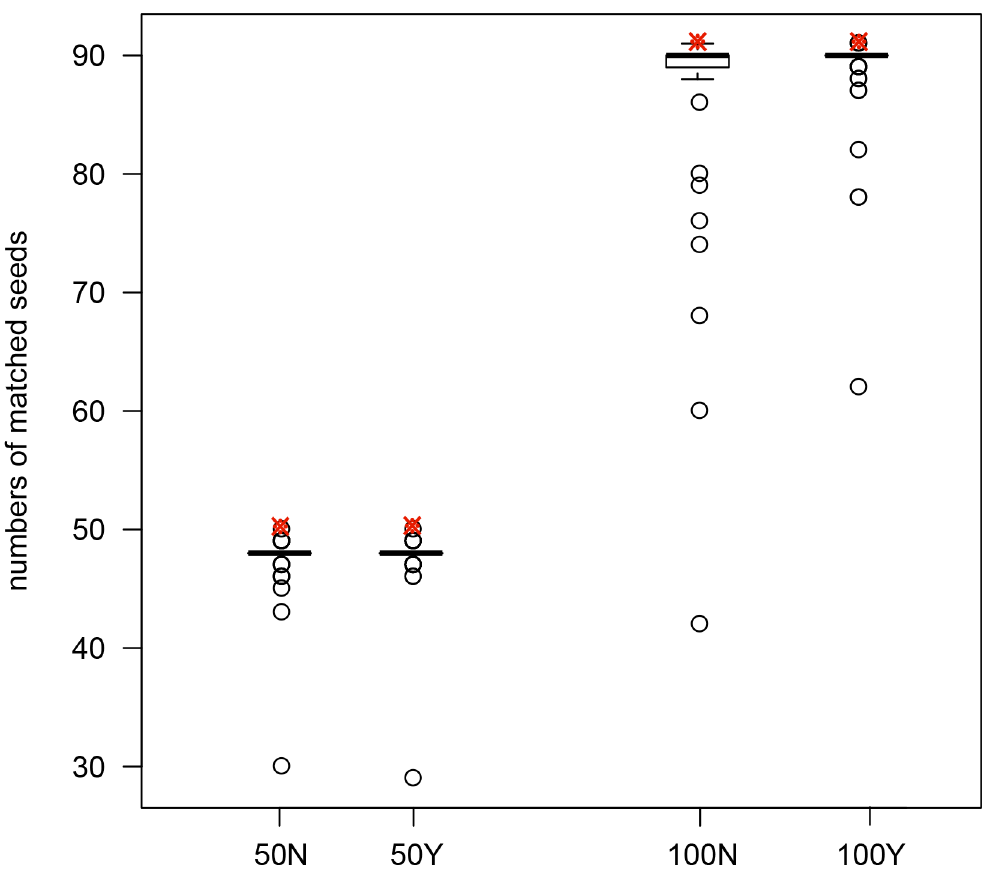
Fig 10. Comparison of the performance of the FIP with and without replacement in random sampling. 50N and 100N were top 50 and top 100 genes in the ranking list with and without replacement, respectively. 50Y and 100Y were top 50 and top 100 genes in the ranking list with back, respectively. Asterisks present our